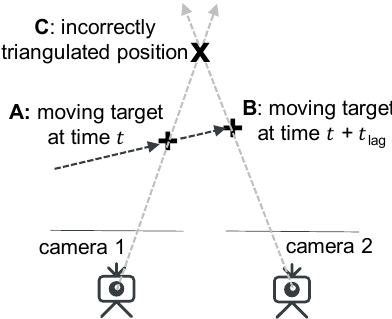
Figure 5. Incorrectly triangulated position caused by ignoring the time lag of camera 2. Even a small time difference between cameras could cause significant unexpected measurement error.